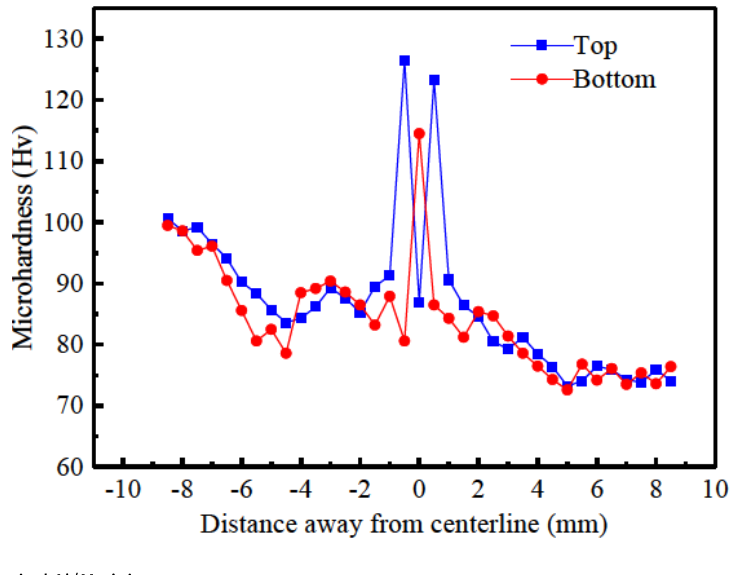
Figure 7: Hardness of the typical Al/Mg joint